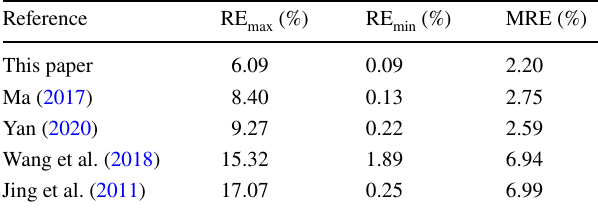
Table 5 Comparison of optimization models